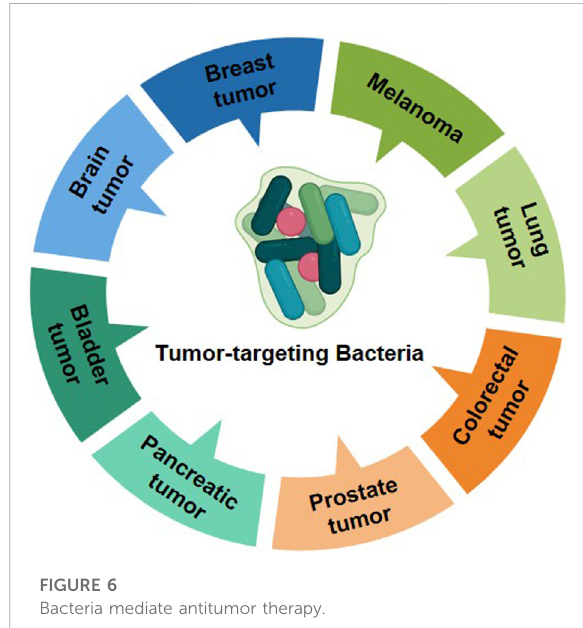
FIGURE 6 Bacteria mediate antitumor